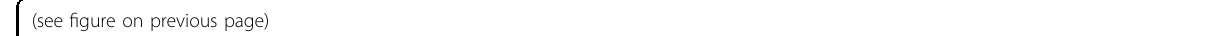
Fig. 1 Mild and sustained stimulation with H 2 O 2 modulates mitochondrial morphology and induces Parkin-mediated mitophagy. A EGFP-C1 (as a control) or EGFP-Parkin were transfected into cells before 0 h and 12 h of H 2 O 2 treatment. Mitochondria were stained with MitoTracker Red (red). Scale bars, 10 μ m. B Cells transfected with EGFP-C1 or EGFP-Parkin were incubated with 100 μΜ H 2 O 2 for 0 h, 12 h, or 18 h. The cells were immunostained with an anti-TOMM20 antibody (red). Scale bars, 10 μ m. C Mitochondrial morphology was quantitatively analyzed using the MiNA ImageJ macro tool based on fl uorescent images of TOMM20 (~20 cells for each analysis). Unpaired t- test; ns, not signi fi cant; * P < 0.05; *** P < 0.001; **** P < 0.0001. The data are presented as the mean ± SD. D HeLa cells were transfected with the mKeima- Red-Mito-7 plasmid along with EGFP-Parkin or EGFP-C1 (as a control) and then treated with 100 μΜ H 2 O 2 for 0 h, 12 h, or 18 h. The white arrows and dashed box show the red fl uorescent dots of Keima excited at 560 nm. Scale bar, 10 μ m. E The fl uorescence intensity of TOMM20 was analyzed by ImageJ in three independent experiments, and the results were subjected to statistical analysis. Ns, not signi fi cant; ** P < 0.01. F Cells were transfected with EGFP-C1 or EGFP-Parkin plasmids and treated with 100 μΜ H 2 O 2 for 0 h, 12 h, or 18 h. The levels of the mitochondrial markers TFAM, TOMM40, and TOMM20 were evaluated by WB analysis. N = 3; ns, not signi fi cant; ** P < 0.01. The quanti fi ed results are presented as the mean ±